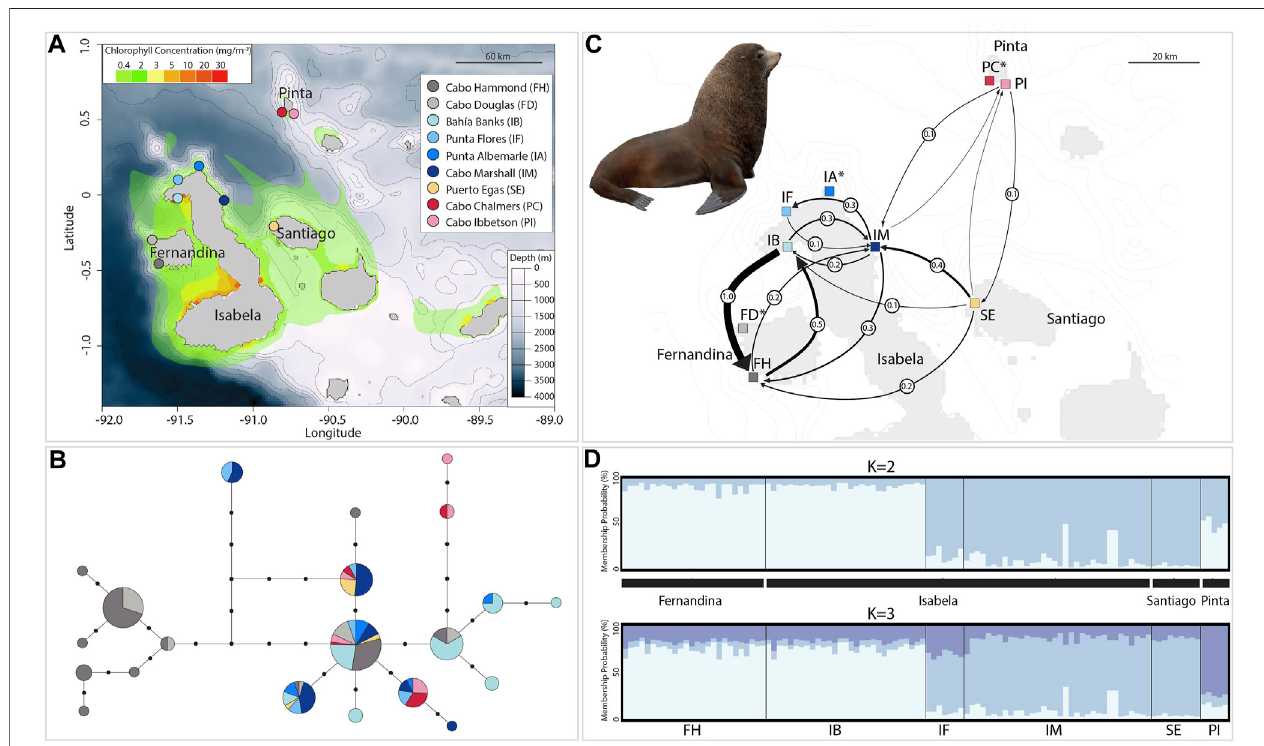
FIGURE 1 | Geographic distribution of genetic diversity, gene fl ow, and genetic structure in the Galapagos fur seal. (A) Map ofthe Galapagos Islands with the nine breeding rookeries studied (inset) with details about bathymetry shown in meters and chlorophyll-a concentration in mg/m − 3 . (B) Mitochondrial haplotype network with circles representing unique control region haplotypes; the size of the circles is proportional to the number of individuals sharing that particular haplotype and length of branches (black circles) represent steps between haplotypes (missing haplotypes). Colors correspond to haplotypes found on each of the nine rookeries studied (see inset above). (C) Migration estimates based on eight microsatellite markers between six rookeries; black arrows indicate the direction of the gene fl ow between rookery pairs, and the thickness of each arrow represents the relative amount of migrant exchange ( Nm : circles over arrows). Arrows with less than 0.1 migrants per generation are not shown ( see Supplementary Figure S4 for all connections). Rookery names with asterisk were excluded from gene fl ow analyses. (D) STRUCTURE plot of genetic assignment for 110 individuals (vertical lines) of six rookeries based on Bayesian analysis at eight microsatellites showing K = 2 suggested by the Δ K method (top) and K = 3 after the Puechmille method based on MedMeaK or MedMedK (bottom). Rookery abbreviations as the inset in (A) and black blocks denotes island origin. Illustration reproduced with permission from Lynx Edicions ©